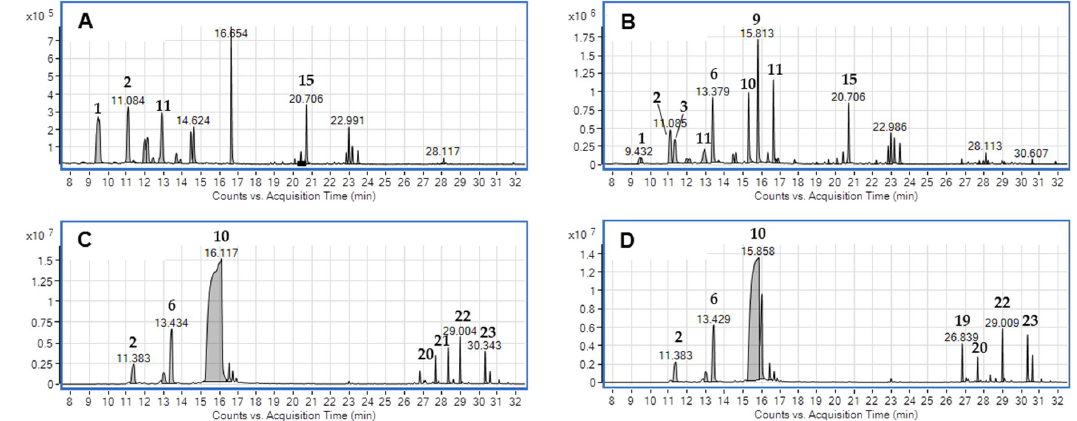
Figure 3. Representative total ion chromatograms for column ( A ), labellum ( B ), sepals ( C ), and petals ( D ) of the new hybrid, Cymbidium “Sunny Bell” flower analyzed by HS-SPME-GC-MS.